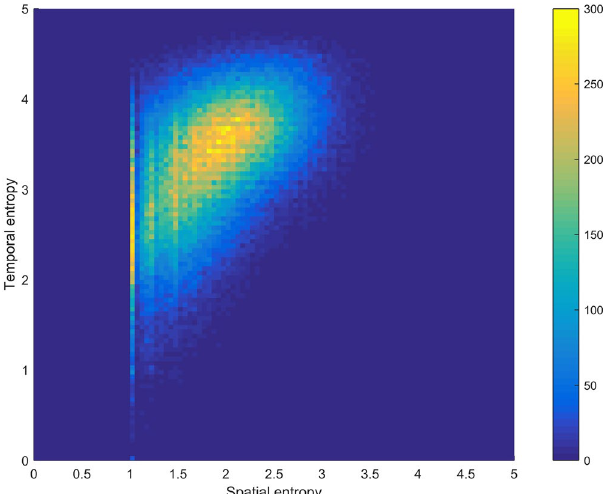
Figure 5. Spatiotemporal joint distribution. The heat map is produced based on a scatter plot, where every dot represents a passenger’s spatial-temporal regularity with its two coordinates being his or her spatial and temporal entropies, and multiple dots may overlap. The grid to support the heat map is 100 × 100 on [0, 5] × [0, 5], i.e., the grid size is 0.05. The degree of overlapping is visible according to different colours with the colour legend to the right of the heat